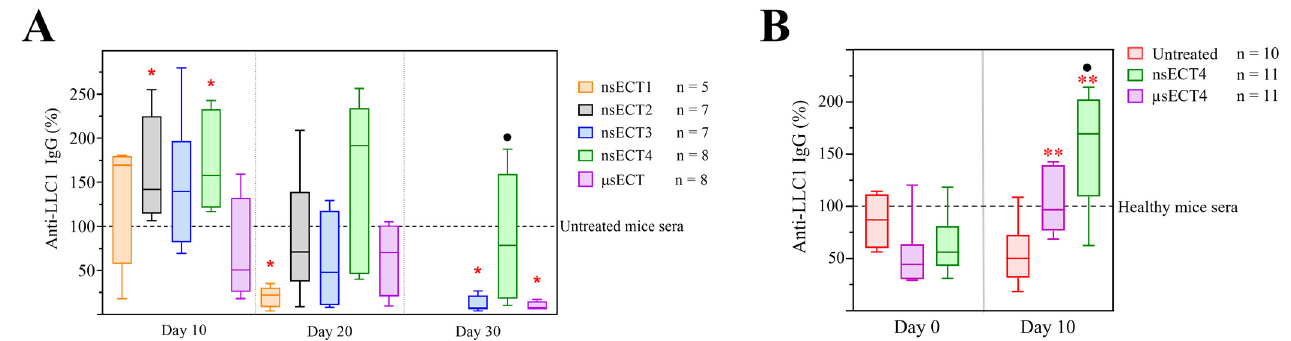
Figure 8. The relative percent of anti-LLC1 IgG antibodies in time-dependent ( A ) and time- independent ( B ) study. Data was normalized according to ( n = 7) untreated tumour-bearing ( A ) and ( n = 6) healthy mice ( B ). Statistically significant (* p < 0.05; ** p < 0.005) differences compared to untreated group; significant differences ( • p < 0.05) compared to the µ sECT group. Flow cytometry was performed with Amnis FlowSight.